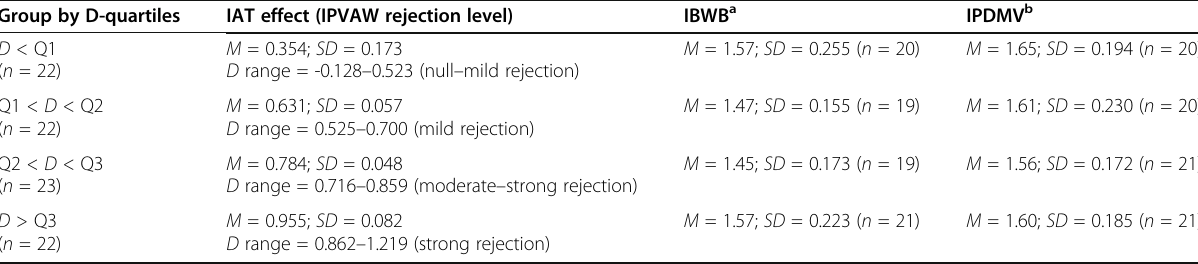
Table 3 Preliminary results comparing GV-IAT and explicit measures Group by